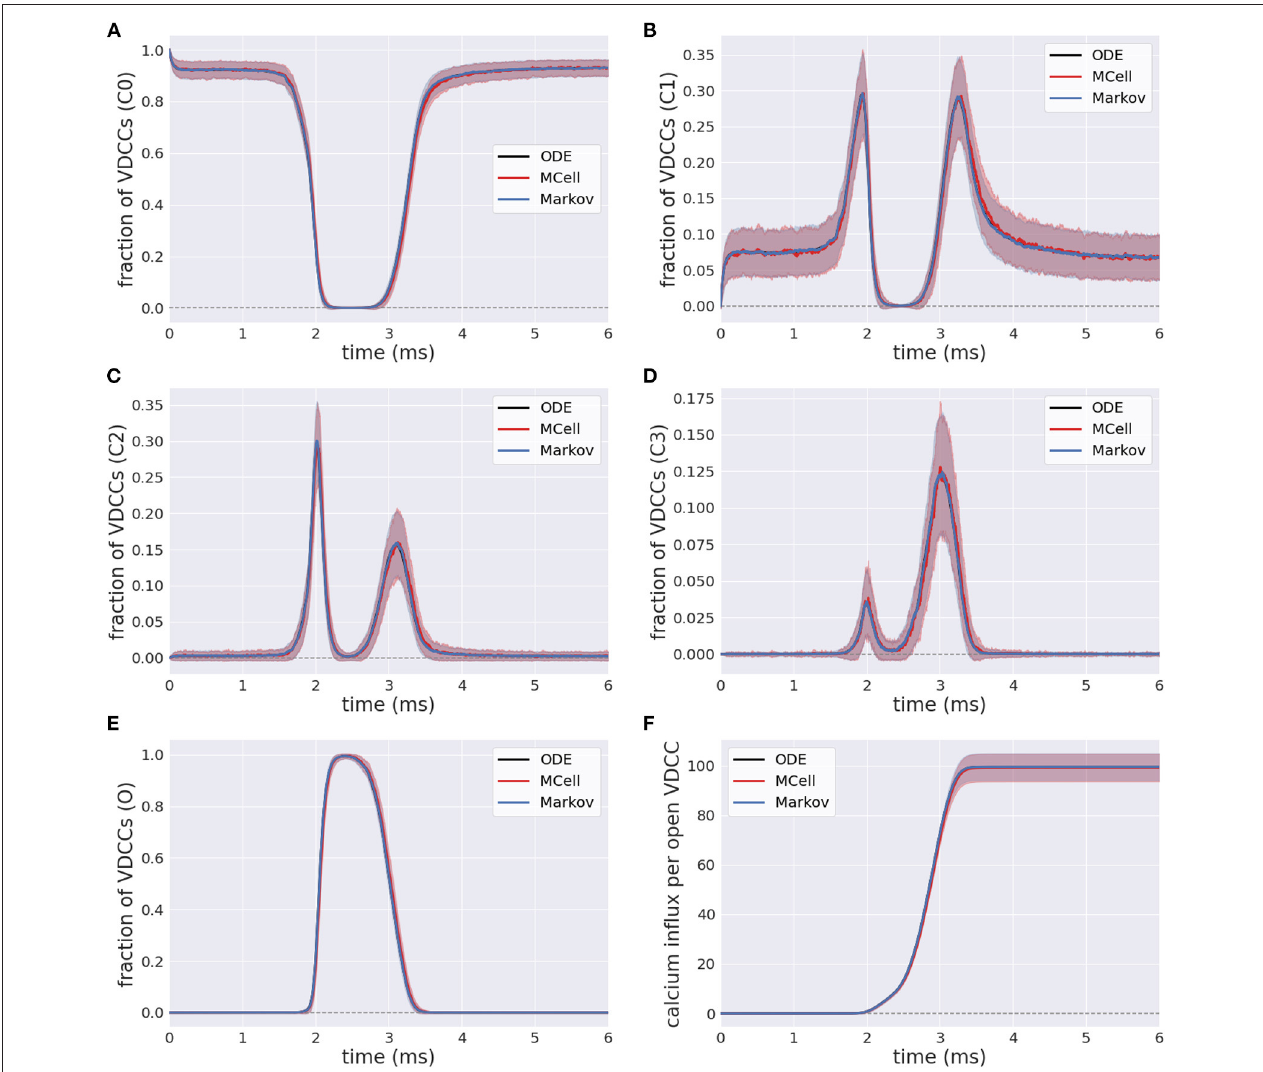
FIGURE 6 | Fraction of voltage-dependent calcium channels (VDCCs) in each state: (A–D) Internal closed channel states, C0-C3, and (E) The open channel state, O. (F) Calcium influx through open VDCCs in response to action potential stimulus for stochastic MCell, Markov, and deterministic ODE forward Euler simulation.